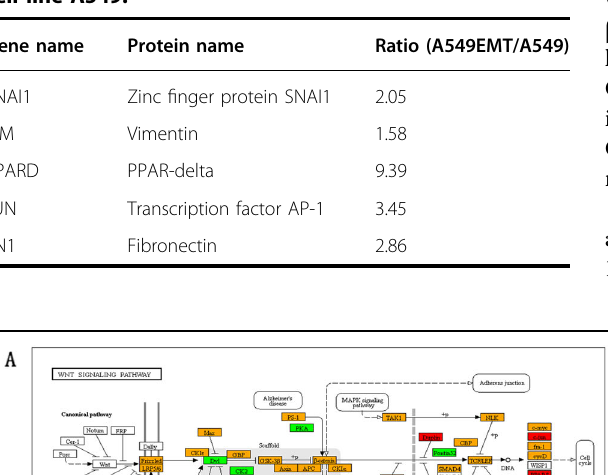
Table 1 Differentially expressed downstream target genes of β - catenin before and after EMT in the lung ADC cell line A549.